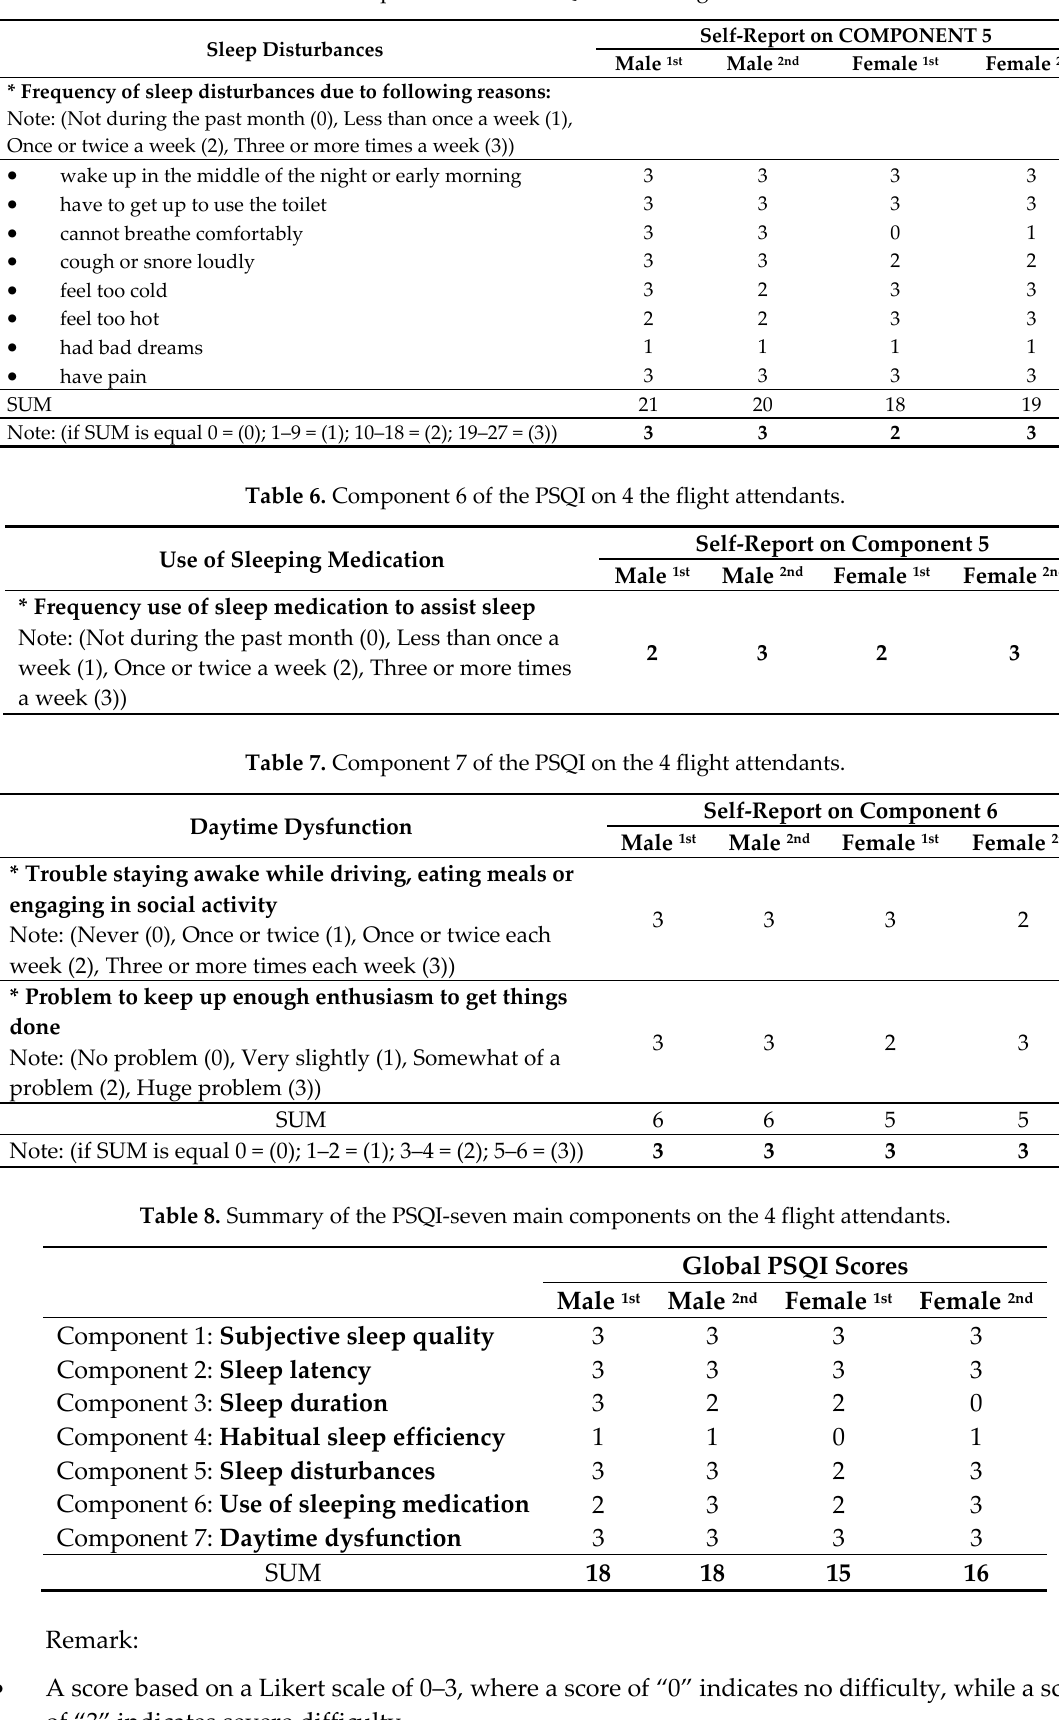
Table 5. Component 5 of the PSQI on the 4 flight attendants.